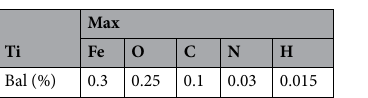
Table 1. Titanium Grade2 chemical